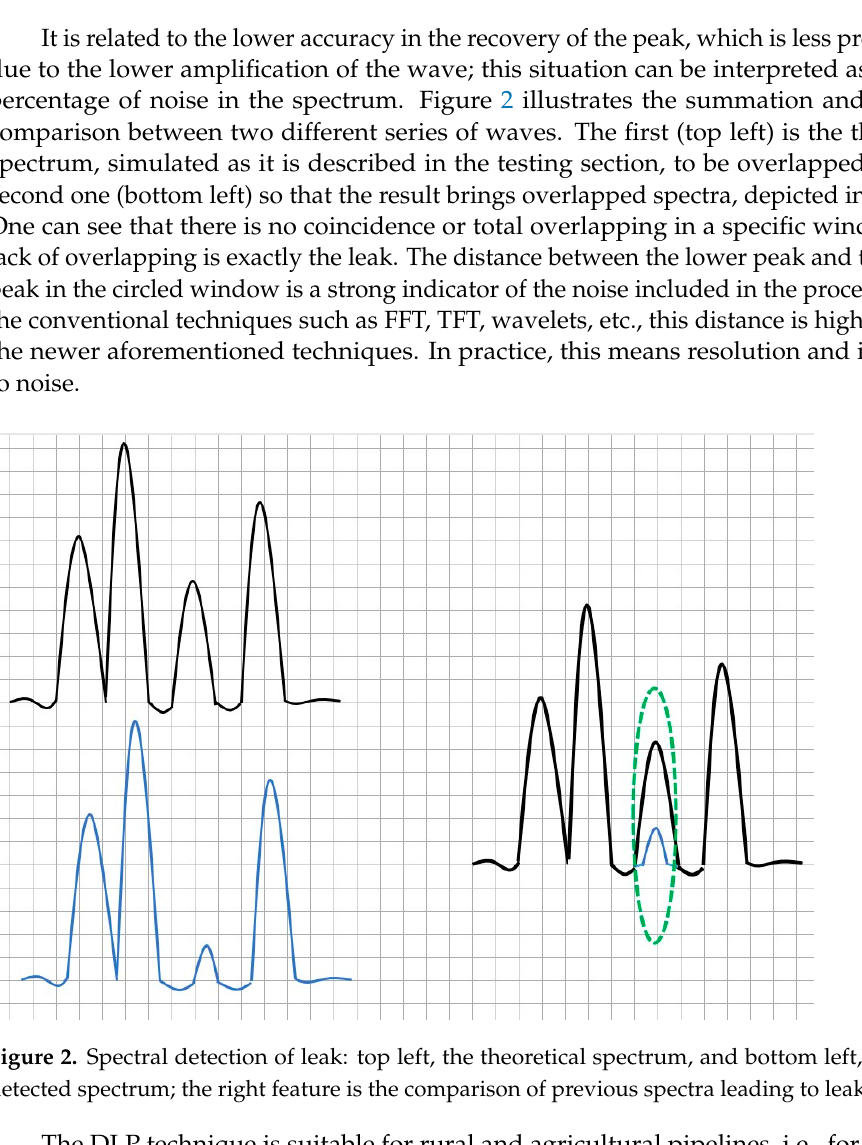
Figure 1. Leakage mechanism after a pressure wave within a pipe.